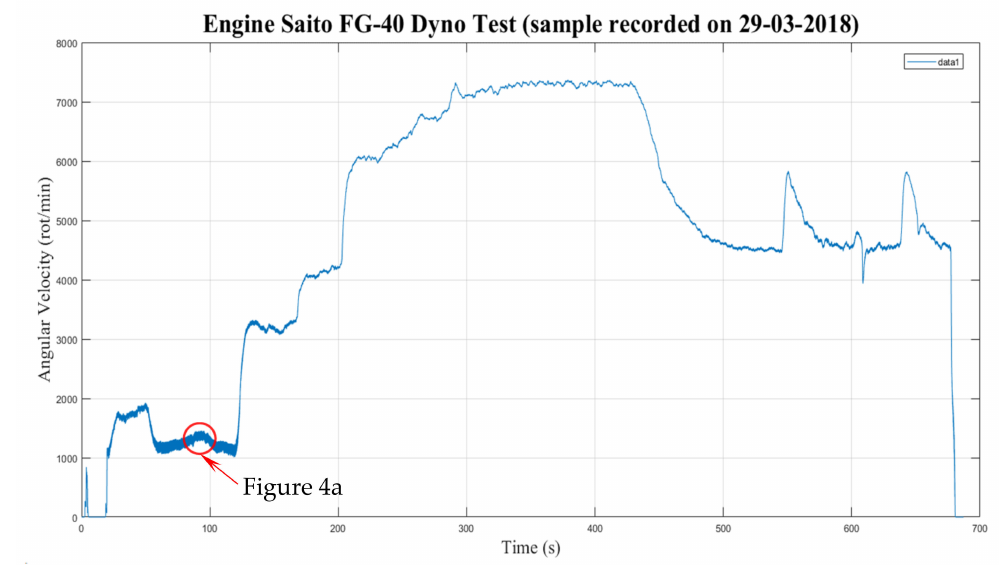
Figure 3. Speed evolution of the Saito FG-40 engine during an experimental